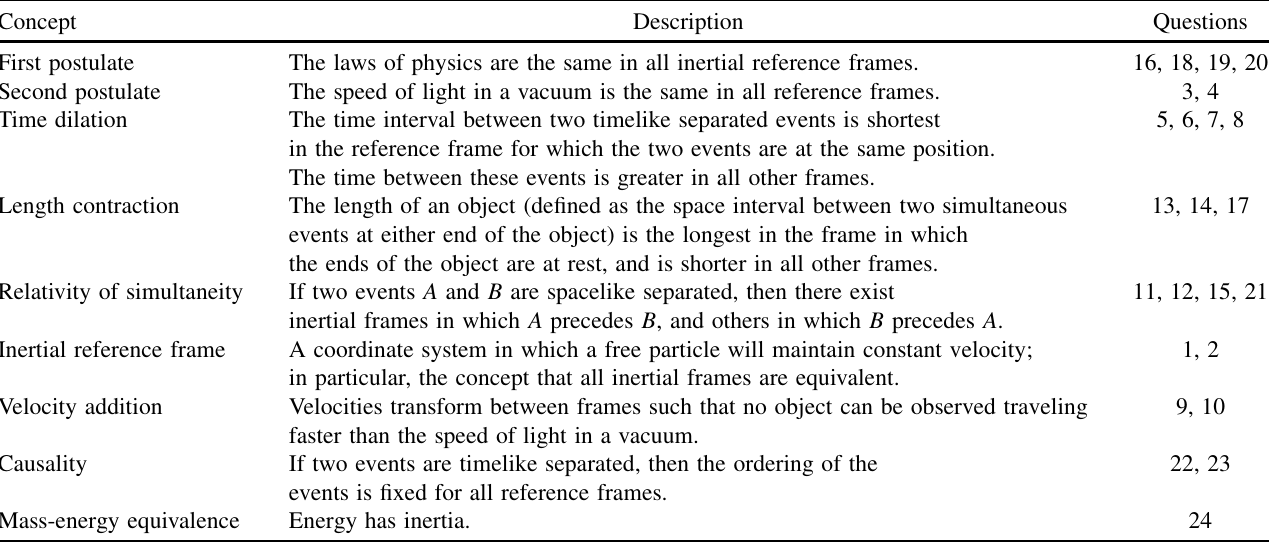
TABLE I. The concepts tested by the RCI. In the questions column are the question numbers we classified as associated with each concept. Although some questions clearly test more than one concept, we have allocated each question to only one